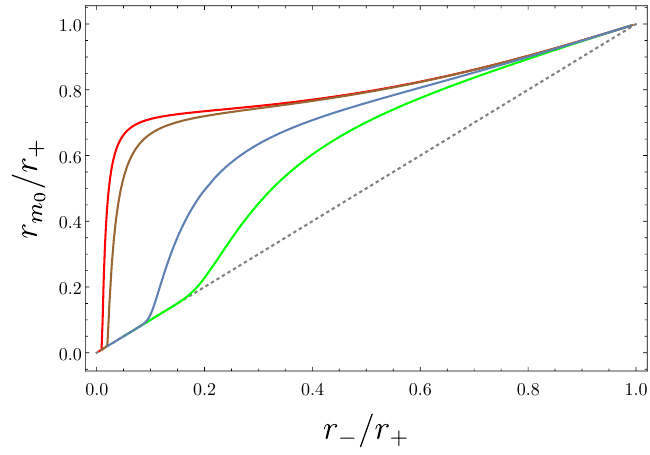
vs. r − /r + for several different values of r + /‘ . The 0